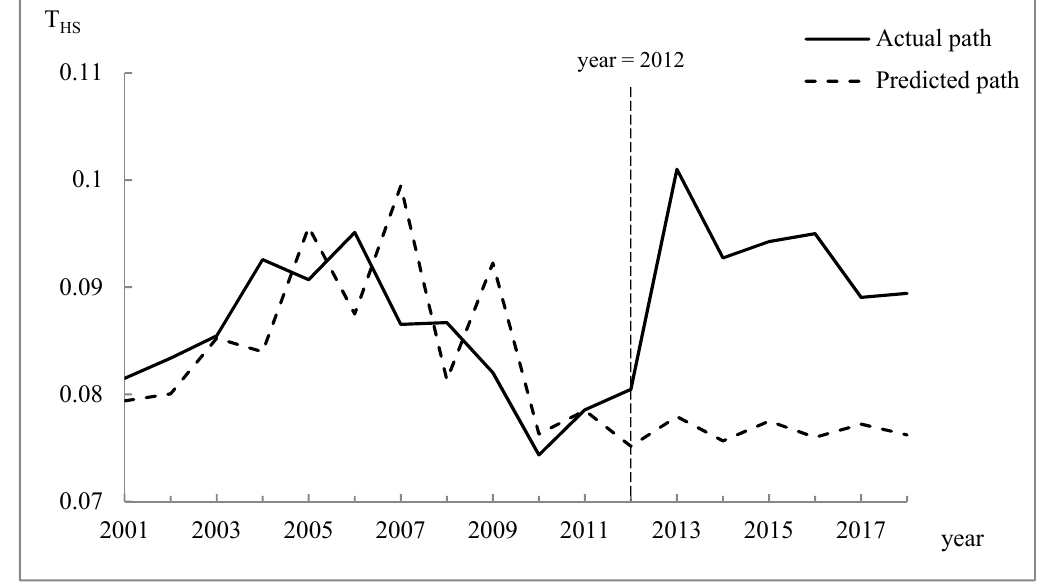
Figure 3. Actual and predicted paths of the T HS index from 2001 to 2018.